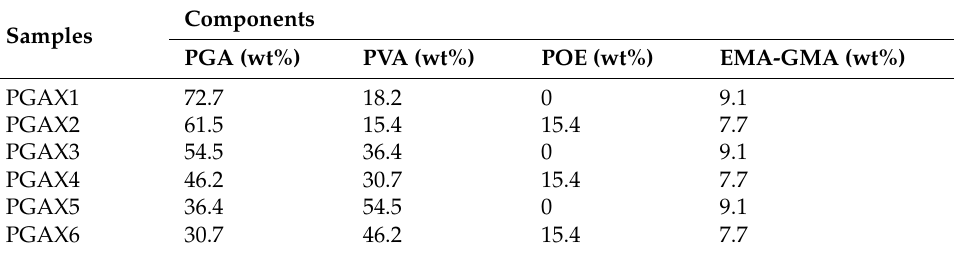
Table 1. Formulations of samples for batch